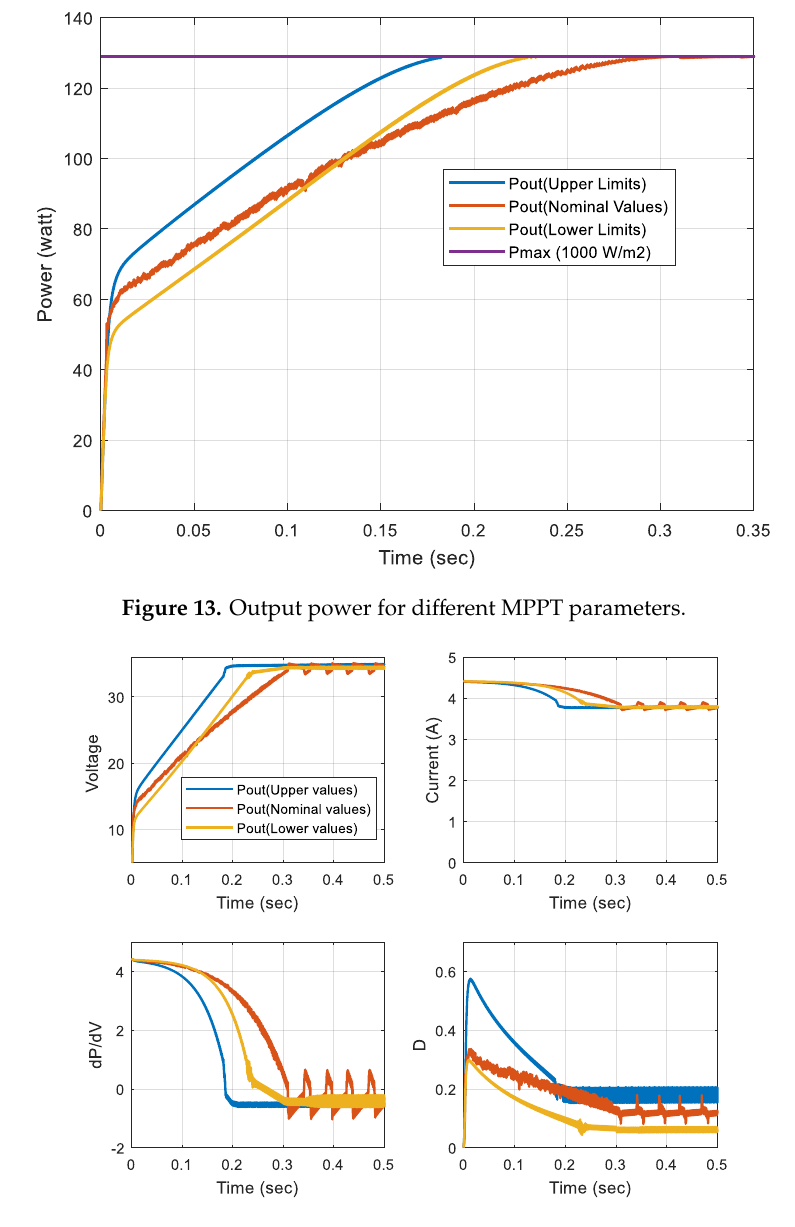
Figure 15. Output power vs . maximum power for a combination of step and ramp values of irradiance at 25 ℃.